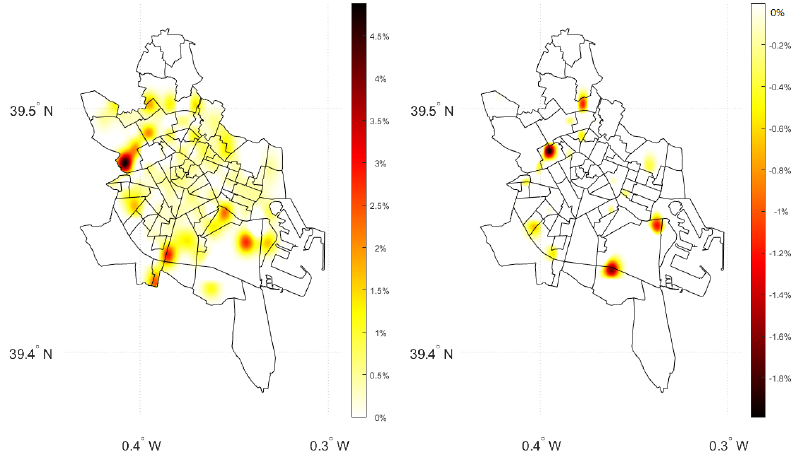
Figure 16. Posterior mean fractional growth (left panel) and (right panel) decay of emergency calls per week in Valencia (2010–2019).